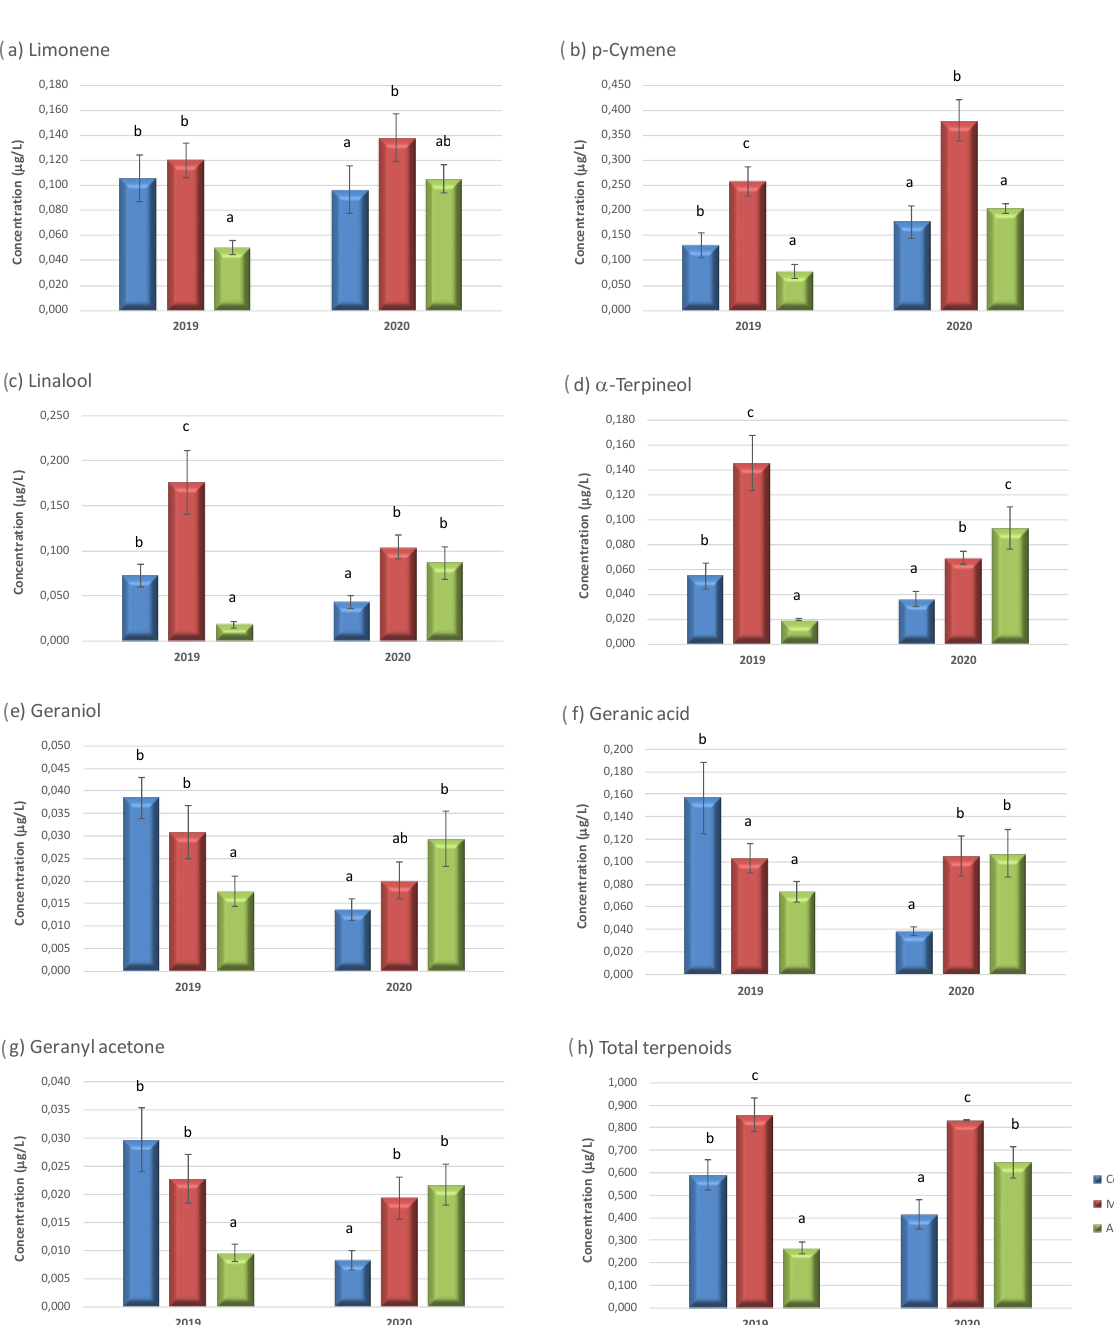
Figure 1. Terpenoids concentration (µg/L) in grapes from control, methyl jasmonate (MeJ) and nanoparticles doped with MeJ (ACP-MeJ) foliar treatments, in 2019 and 2020 seasons. All parameters listed with their standard deviation ( n = 3). For each season and compound, different letters indicate significant differences between samples ( p ≤ 0.05).